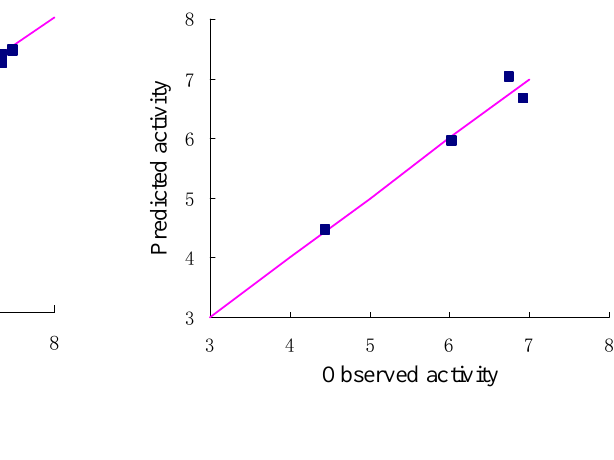
Figure 3. Graph of observed versus predicted Figure 4 . Graph of observed versus predicted activities of the training set. activities of the test